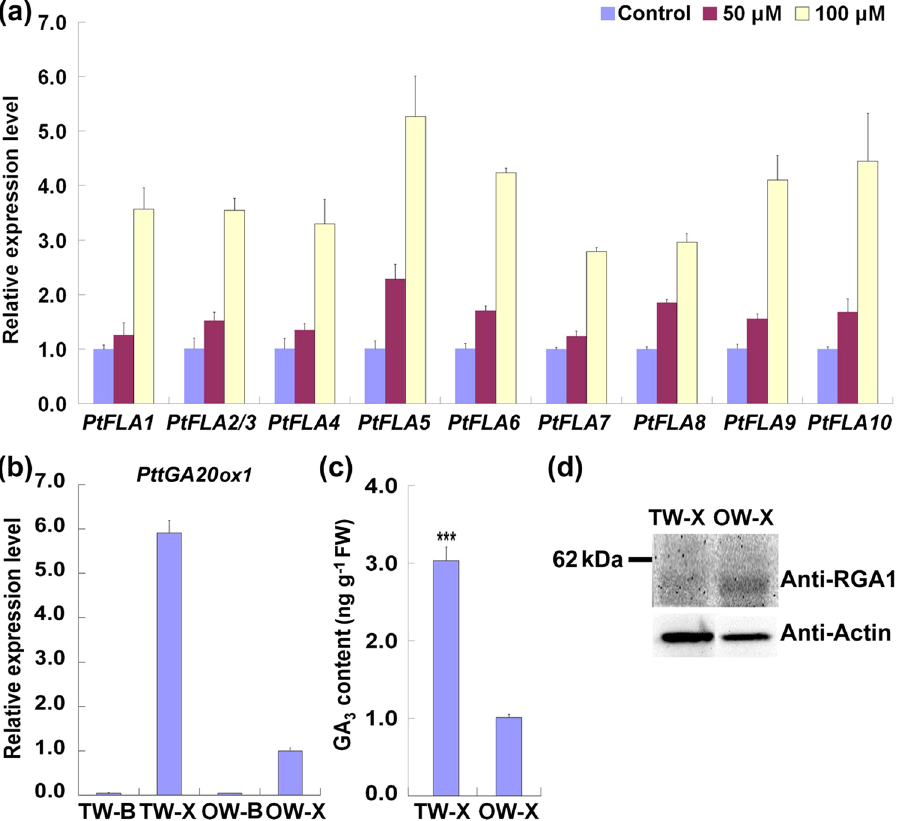
Figure 5. Asymmetrical distribution of GA 3 during TW formation. ( a ) Expression analysis of PtFLAs in GA 3 treated poplar stem sections. The expression level of genes in control was set to 1. ( b ) qRT-PCR analysis of PttGA20ox1 during TW formation. Gene expression in the OW xylem was set to 1. ( c ) GA 3 content in the xylem tissues of the TW and OW sides. *** Indicates a significant difference in comparison to OW-X at P < 0.001 (Student’s t-test). ( d ) Western blotting analysis of the poplar DELLA protein in the xylem of TW and OW sides. About 30 μ g proteins were separated by 10% SDS-PAGE and hybridized with AtRGA1 antibodies (Anti-RGA1) or plant actin antibodies (Anti-Actin), respectively. TW-B, the bark tissues of TW side; TW-X, xylem tissues in the TW side; OW-B, the bark tissues of OW side; OW-X, xylem tissues in the OW side. Error bars represent the SDs from three biological